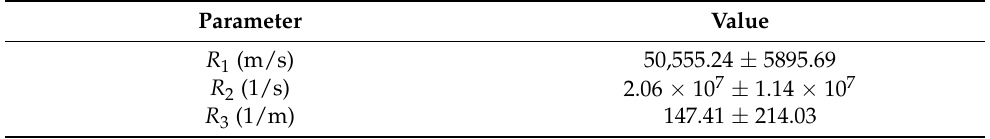
Table 3. Parameters of dry layer